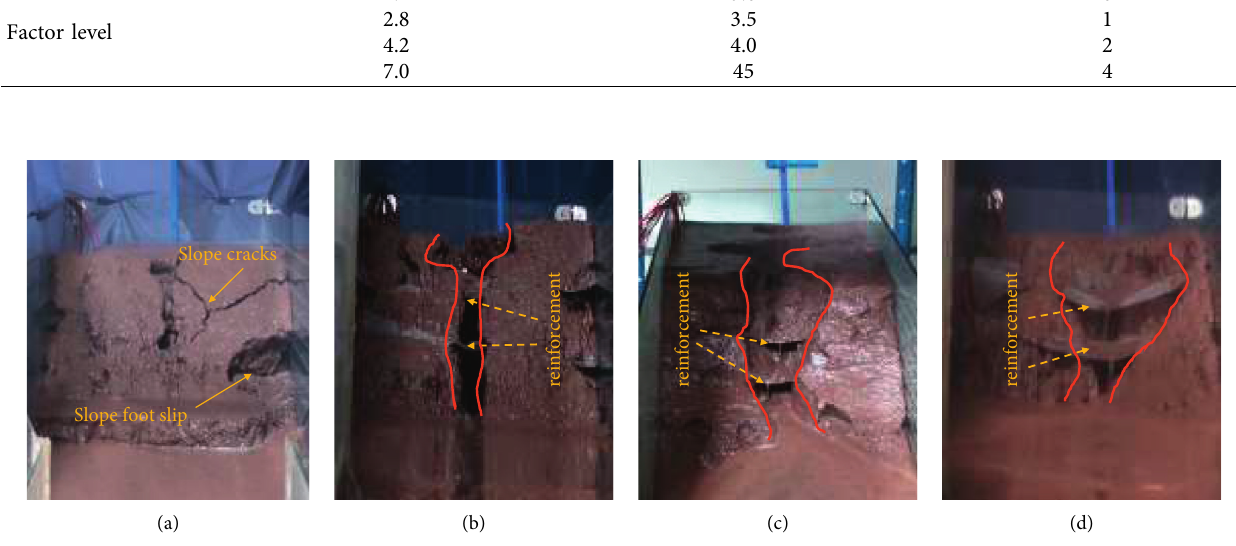
Figure 5: Final erosion failure of reinforced embankment under different rainfall intensities: (a) 14mm/h; (b) 28mm/h; (c) 42mm/h; (d)